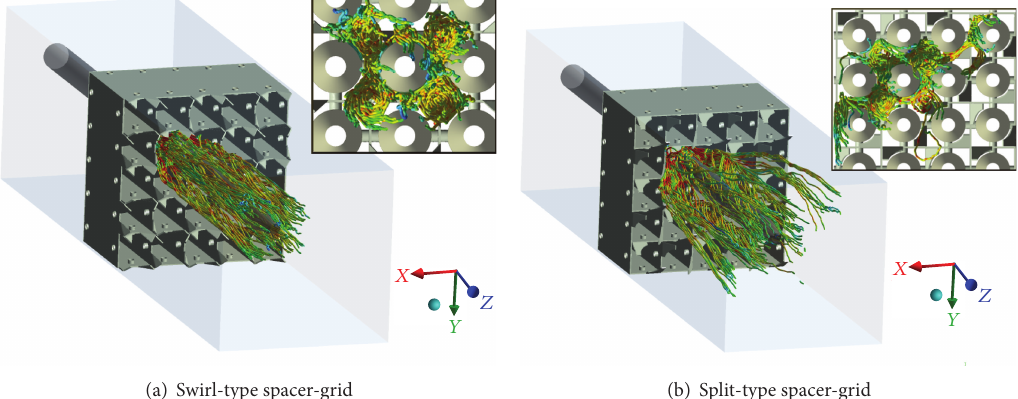
Figure 18: Streamlines of flow leaving the spacer around one rod for split spacer-grid. The streamlines represent the velocity in a chosen time step in a range from 0 to 2.3 m/s of a red-to-blue color scale.